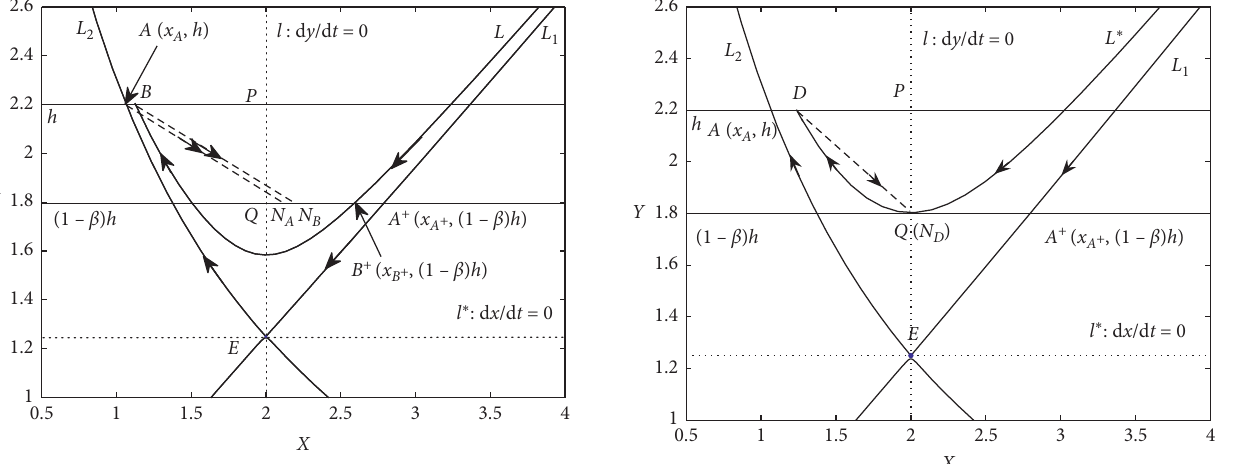
Figure 5: Trajectory L ∗ passing Q and impulse mapping D of case I with parameter values: a � 5 , c � 4 ,d � 6 ,e � 3 , h � 2 . 2, and β � 0 .